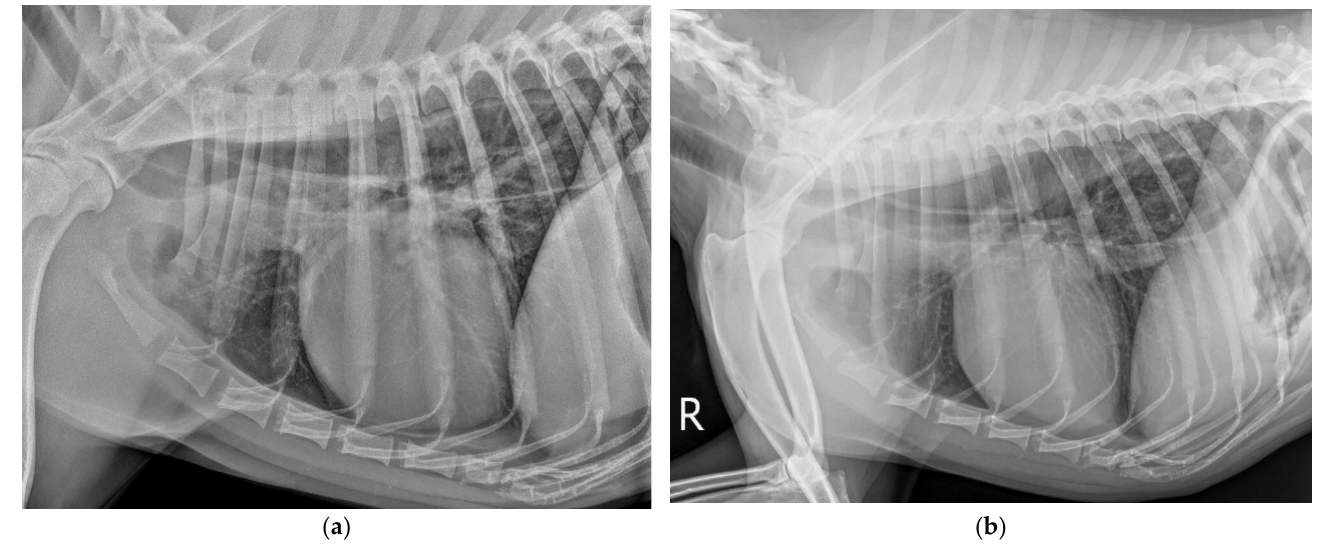
Figure 1. ( a ) Lateral thoracic X-ray at the first consultation. Note the diffuse interstitial pulmonary pattern visible in cranial and diaphragmatic lung lobes, along with a bronchial pattern in the diaphragmatic lobes and esophageal gas distension. ( b ) Lateral thoracic X-ray upon admission to our service (4 weeks later). The pulmonary pattern and esophageal gas distension are visible.